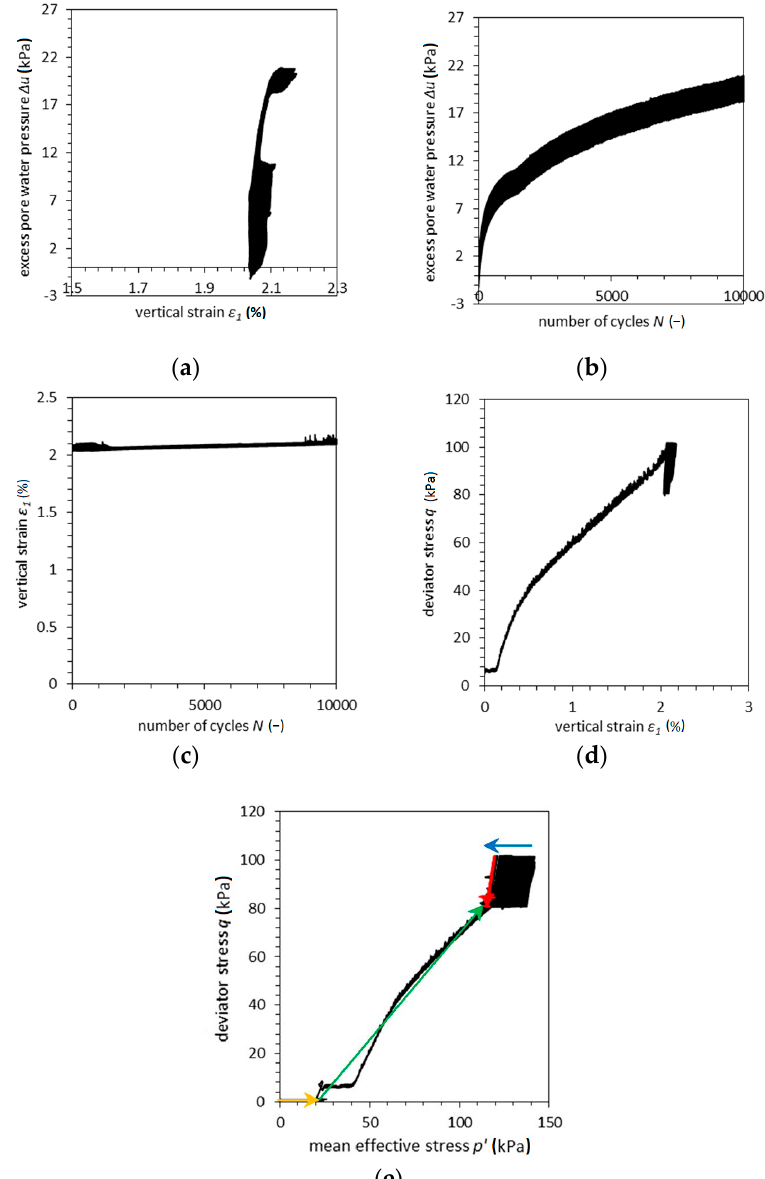
Figure 7. Results of the cyclic triaxial test for sandy silty clay under a confining pressure of 139.7 kPa and under the K 0 consolidation, initial void ratio e 0 = 0.379, K 0 = 0.67—sample 2.3: ( a ) Excess pore water pressure versus vertical strain characteristic, ( b ) excess pore water pressure characteristic versus number of cycles, ( c ) vertical strain characteristic versus number of cycles, ( d ) deviator stress–vertical strain relationship, and ( e ) the deviator stress–mean effective stress relationship (red color—last 10 cycles; arrow color—violet: Saturation phase, green: Consolidation phase, blue: Cyclic loading program).